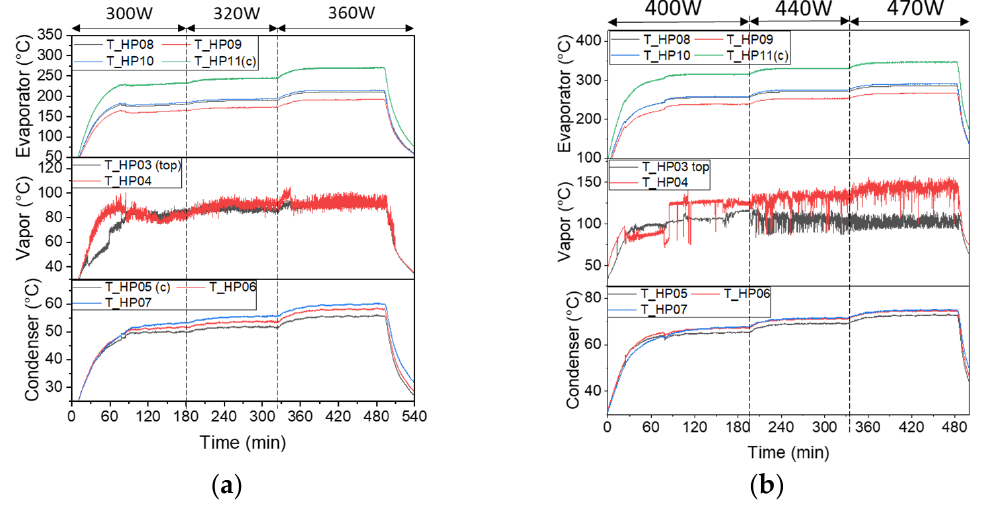
Figure 17. Mock-up-1 temperature evolution with liquid inventory for 1 MW/m 2 and electric copper heater calorimetric power: ( a ) 300, 320, and 360 W (heat flux: 0.61, 0.65, and 0.73 MW/m 2 ); ( b ) 400, 440, and 470 W (heat flux: 0.82, 0.9, and 0.9 MW/m 2 ). Comparing the temperatures at the three positions (those of the evaporator, vapor, and condenser) of the mock-up, the evaporator temperatures have a much smoother evolution than the ones obtained with the laser. During the testing with electric power, it was observed that the two vapor temperatures started to separate at high heat loads of around 0.9 MW/m 2 . When comparing the vapor temperature plots from Figure 17a,b, the two temperatures are practically identical for low powers (Figure 17a). However, for the high loadings (Figure 17b), the measurement of T-HP04 close to the evaporator increases by 40 ◦ C while the one of T-HP03 close to the condenser stays around 100 ◦ C even when the loading is